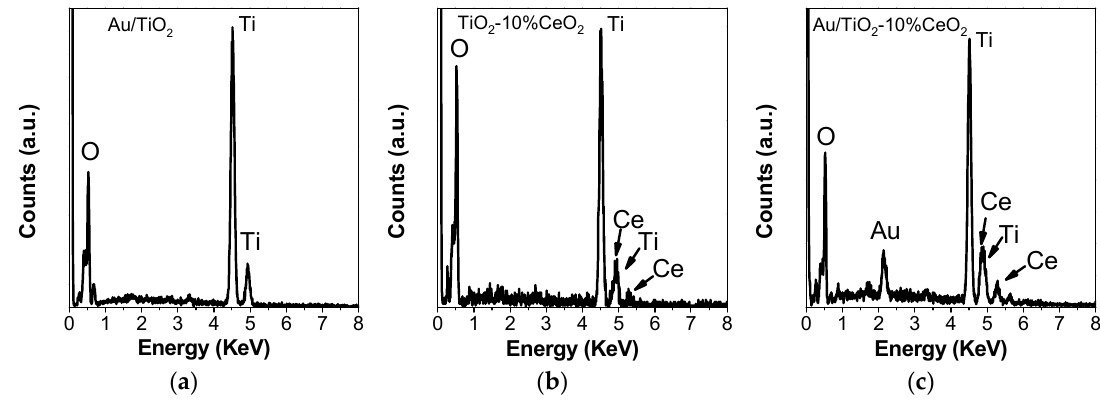
Figure 6. EDX (Energy ‐ dispersive X ‐ ray spectroscopy) spectra of ( a ) Au/TiO 2 , ( b ) TiO 2 ‐ 10%CeO 2 and ( c ) Au/TiO 2 ‐ 10%CeO 2 samples.